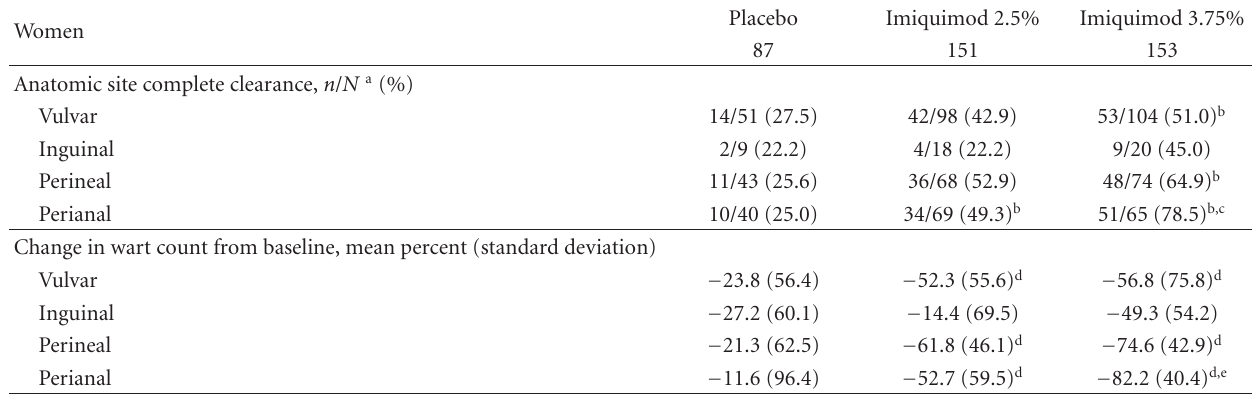
Table 2: Anatomic site-specific clearance rates, per protocol population.